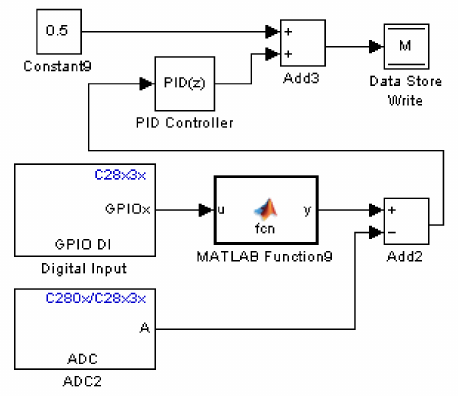
Figure 5. Voltage control